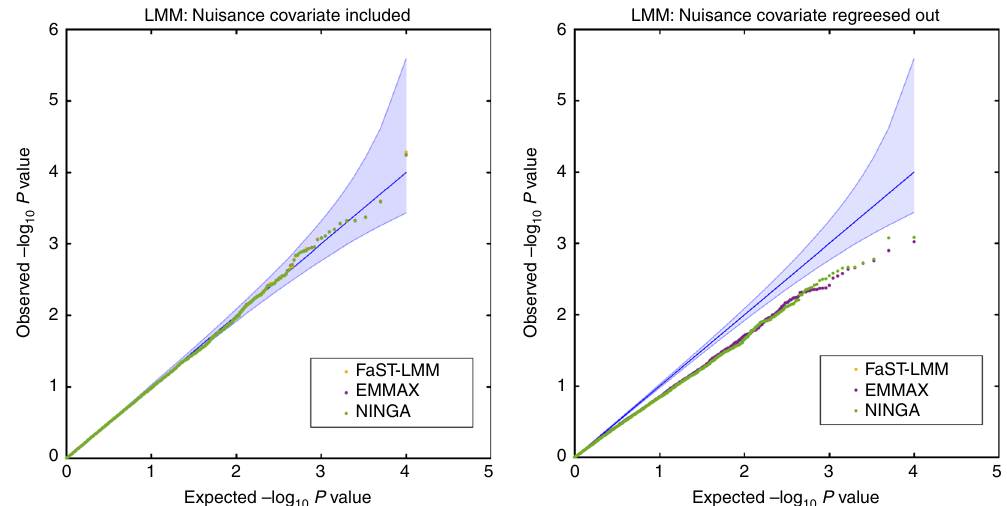
Fig. 4 Comparison of parametric P -values from different software packages for controlling heritable nuisance covariate in GWA (Simulation 5). Results shown for the distribution of null ( β SNP = 0 and β nuisance = 0). P -values from score statistic based the simpli fi ed REML function using non-iterative random effect estimator (NINGA), FaST-LMM and EMMAX, for the GRM from 4000 unrelated individuals with 5000 realizations when nuisance covariate is included in the LMM (left panel) and residualised phenotypes are fi tted to LMM (right panel). The nuisance covariate heritability is 60%, due to 10 SNPs 25 using the additive model. There is no apparent differences between the packages when the nuisance covariate is included in the LMM. However, fi tting the LMM to the residualised phenotypes produces invalid results in this setting of correlation between SNP and nuisance covariates. Con fi dence bounds created with the results of ref. 59 , where ordered P -values follow beta distribution (see the Supplementary Note 1 for more details on simulation settings)